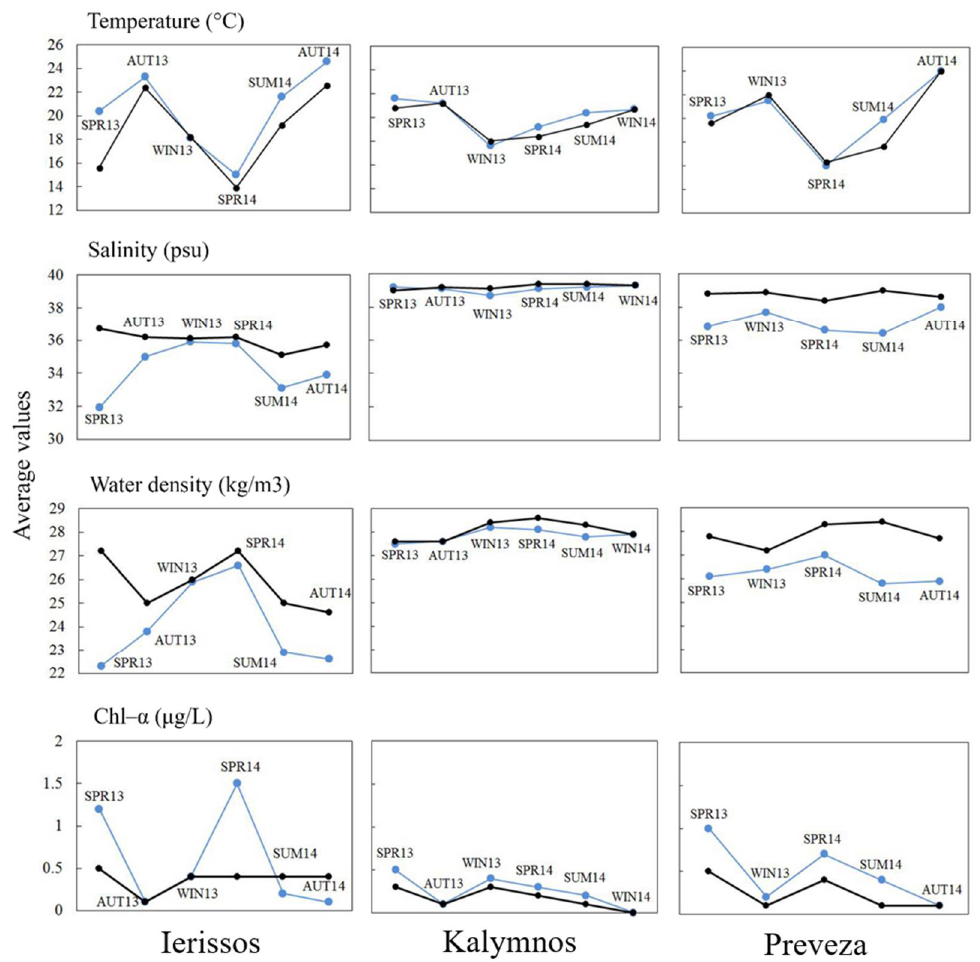
Figure 3. In situ environmental parameters for the three artificial reefs. Spring: SRR; Summer: SUM; Autumn: AUT; Winter: WIN; 13 and 14 indicate the years 2013 and 2014 respectively; Blue: Surface layer data; Black: Water column data.